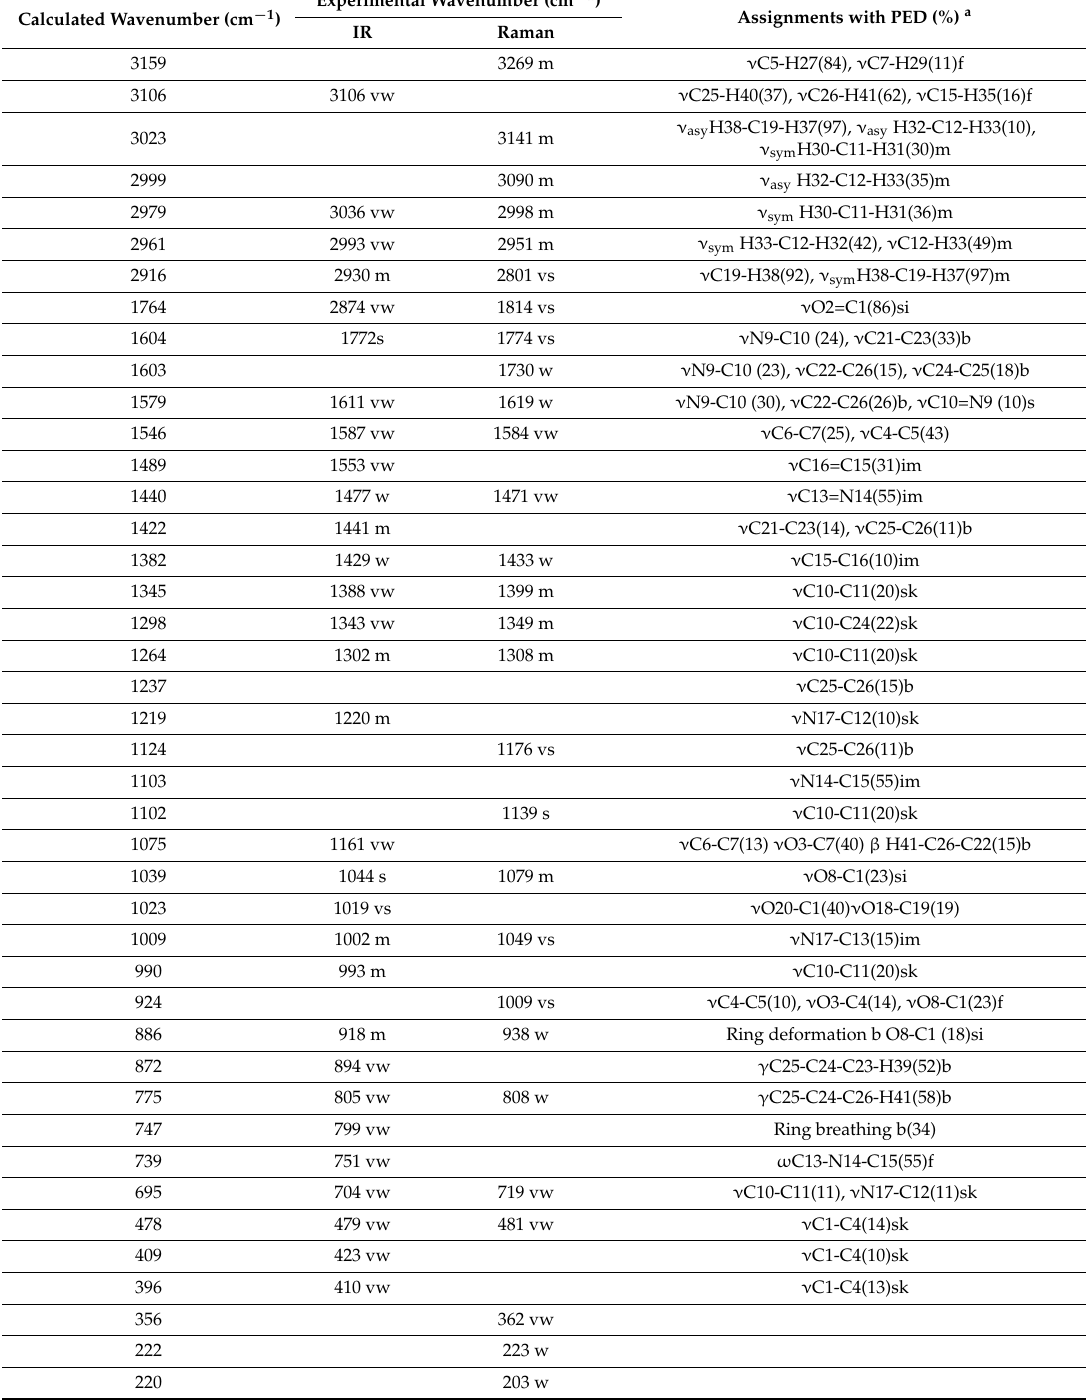
Table 4. Vibrational assignments of compound 5 based on potential energy distribution (PED) analysis. Calculated Wavenumber (cm − 1